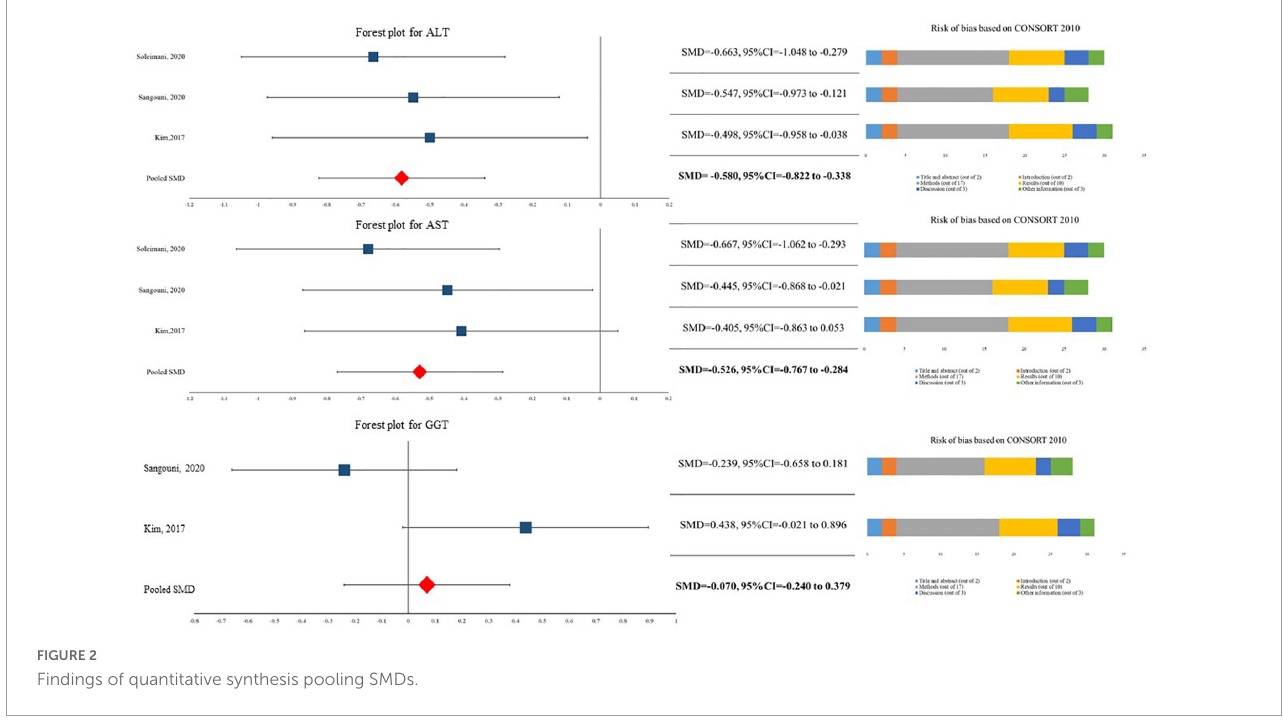
FIGURE2 Findings of quantitative synthesis pooling SMDs.